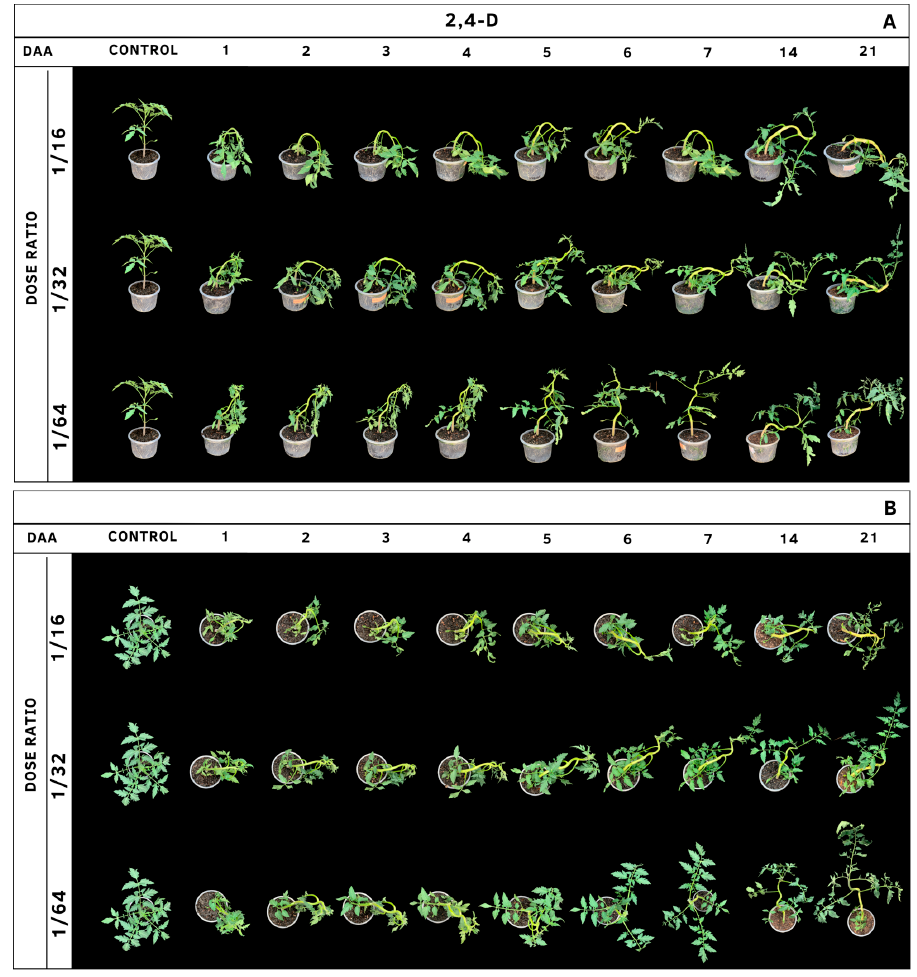
Figure 1. Symptoms evolution in tomato plants due to simulated 2,4-D drift at dose ratios 1/16D, 1/32D, and 1/64D (146.56, 73.28, and 36.64 g a.e. ha − 1 , respectively) of the recommended dose (D). Evaluations were made from 1 to 7, 14, and 21 days after application (DAA). Front view ( A ) and top view ( B ) of tomato plants a ff ected by simulated drift.